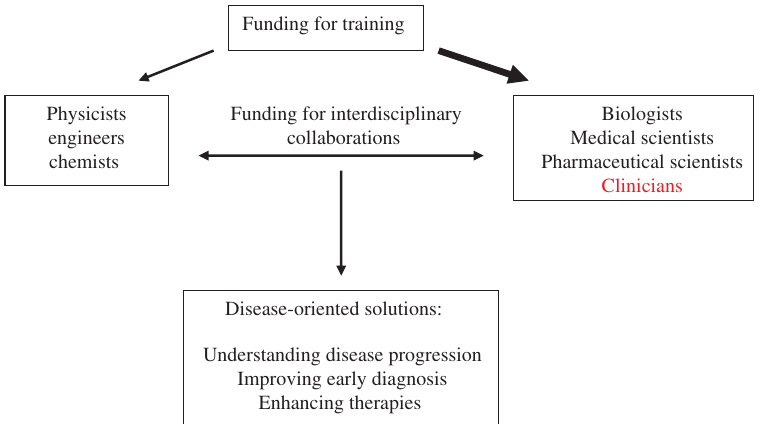
Figure 1 Schematic of steps needed for heading toward nanotechnology-based solutions for a particular